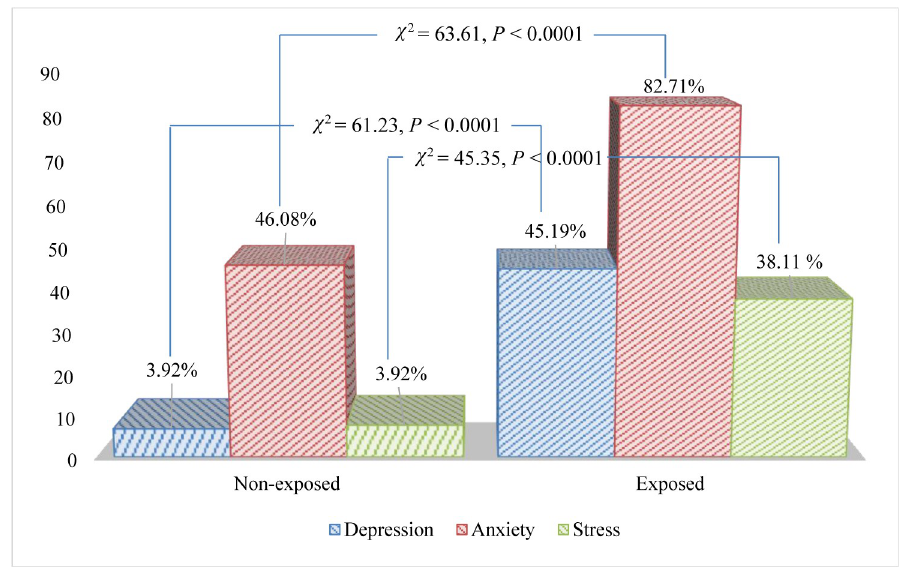
Fig 3. Rate/proportion of depression, anxiety and stress among exposed and non-exposed groups. their relatives, 48.45% lost their homesteads and 80.52% lost their cultivable land due to the riverbank erosion. Among the exposed respondents, the highest proportion (96.66%) were exposed by losing their cultivable land, followed by the exposure due to losing homesteads/ houses (57.96%). We observed that a higher proportion of the exposed people did not isolate themselves from their family (57.37%), did not abuse substances (95.48%), did not need social support (50.29%) and did not hope to get back their lost cultivable land (74.85%). Table 2 represented the bivariate distribution of outcome variables such as depression, anxi- ety and stress with other risk factors, and their test (Chi-squared test) of associations. As we saw that the proportions of depression and stress were significantly higher for Rajbari District compared to Tangail District (depression: 42.44% versus 29.85%, P = 0.003; and stress: 40.49% versus 15.92%, P < 0.001), the prevalence of anxiety was similar between the two districts (76.83 versus 76.12, P = 0.846). The prevalence of depression, anxiety and stress was higher among the female participants than the males (depression: 43.22% versus 32.99%, anxiety: 78.55% versus 74.49% and stress: 35.96% versus 28.57%) and raised with the increase of age. The respondents who were uneducated, old aged ( > 45 years), had more than 4 children, had no cultivable land and had lower level income showed the highest rate of depression, anxiety and stress disorder compared to their contrary counterparts. Regarding occupation, the depression rate was the highest among the housewives (44.91%), whereas the rate of anxiety and stress disorder was the highest among the day labourers (anxiety: 82.86% and stress: 38.57%). The rates of depression (63.32%), anxiety (95.20%) and stress (54.59%) were significantly higher among the participants who changed their living places within three years compared to their other counterparts. We observed that the prevalence of depression, anxiety and stress was higher among those who lost their livestock (depression: 69.77% versus 35.92%, P < 0.001; anxiety: 95.35% versus 75.18%, P = 0.003; and stress: 55.81% versus 30.63%, P = 0.001), rela- tives (depression: 50.65% versus 36.52%, P = 0.017; anxiety: 83.12% versus 75.66%, P = 0.148; and stress: 48.05% versus 30.15%, P = 0.002), houses (depression: 55.41% versus 22.22%, P < 0.001; anxiety: 92.57% versus 61.59%, P < 0.001; and stress: 47.30% versus 18.41%, P < 0.001)